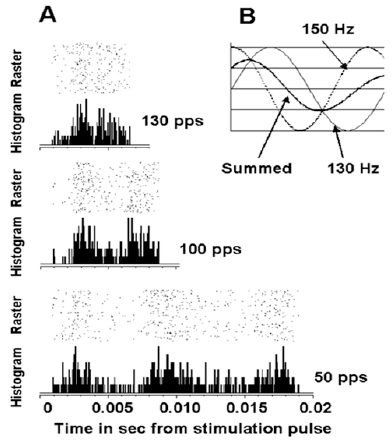
Figure 12. ( A ) A post-stimulus raster and histogram of a cortical neuron recorded in a nonhuman primate using a 50-pps DBS-like stimulation delivered in the vicinity of the STN. The stimulus pulse occurred at time 0, and the raster and histogram show the periodic neuronal activities during the interstimulus pulse intervals. Each dot in the raster represents the onset of an action potential. Each row represents responses to a single DBS pulse. The number of dots in columns across the raster appears in the histogram below each raster. The lengths of the raster and histogram represent the time interval between DBS pulses. In the raster and histogram associated with the 50-pps DBS, a recurring peak of increased neuronal activity is evident. The truncated appearance of the third peak suggests that the time period associated with the frequency of the re-entrant oscillatory activity is not an integer multiple of the time interval between the DBS pulses. This suggests an interaction between the oscillator generating the recurrent activity and the oscillator composed of the DBS spike train ( B ). This observation may be explained by an interaction between a 130-Hz DBS oscillator and a 150-Hz oscillator intrinsic to the neuron.